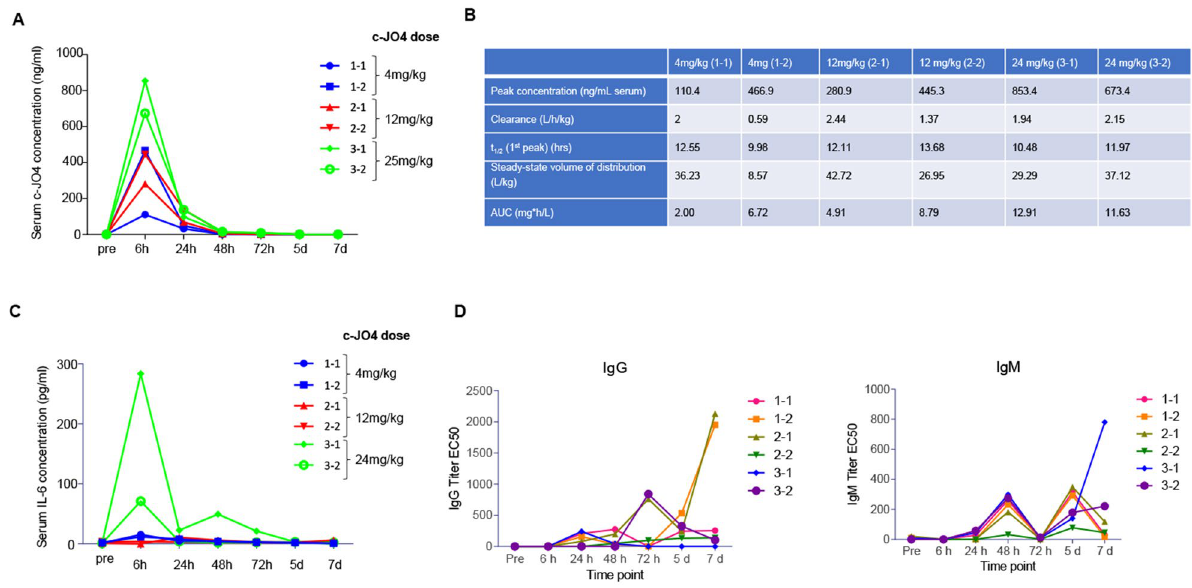
Figure 3. Intravenous dose range finding study in female cynomolgus monkeys. ( A , B ) Pharmacokinetics parameters of c-JO4 in cynomolgus monkeys. ( A ) c-JO4 concentrations in serum collected at indicated time points subsequent to c-JO4 administration were measured by ELISA. Standard curve used to quantify c-JO4 is shown on the right side. ( B ) Pharmacokinetic data calculated by using serum concentration curves of each animal. Units are as indicated. ( C ) Cytokines IL-2, IL-4, IL-5, IL-6, TNF-alpha, and IFN-gamma were measured by cytometric bead array (CBA) (NHP th1/Th2 cytokine kit from BD Biosciences). Only IL-6 was detectable. ( D ) Antibody titers present in serum against c-JO4 were measured by ELISA, using recombinant c-JO4 protein for capture and anti-NHP-IgG-HRP and anti-NHP-IgM-HRP for detection. Shown are IgM and IgG titers as IC 50